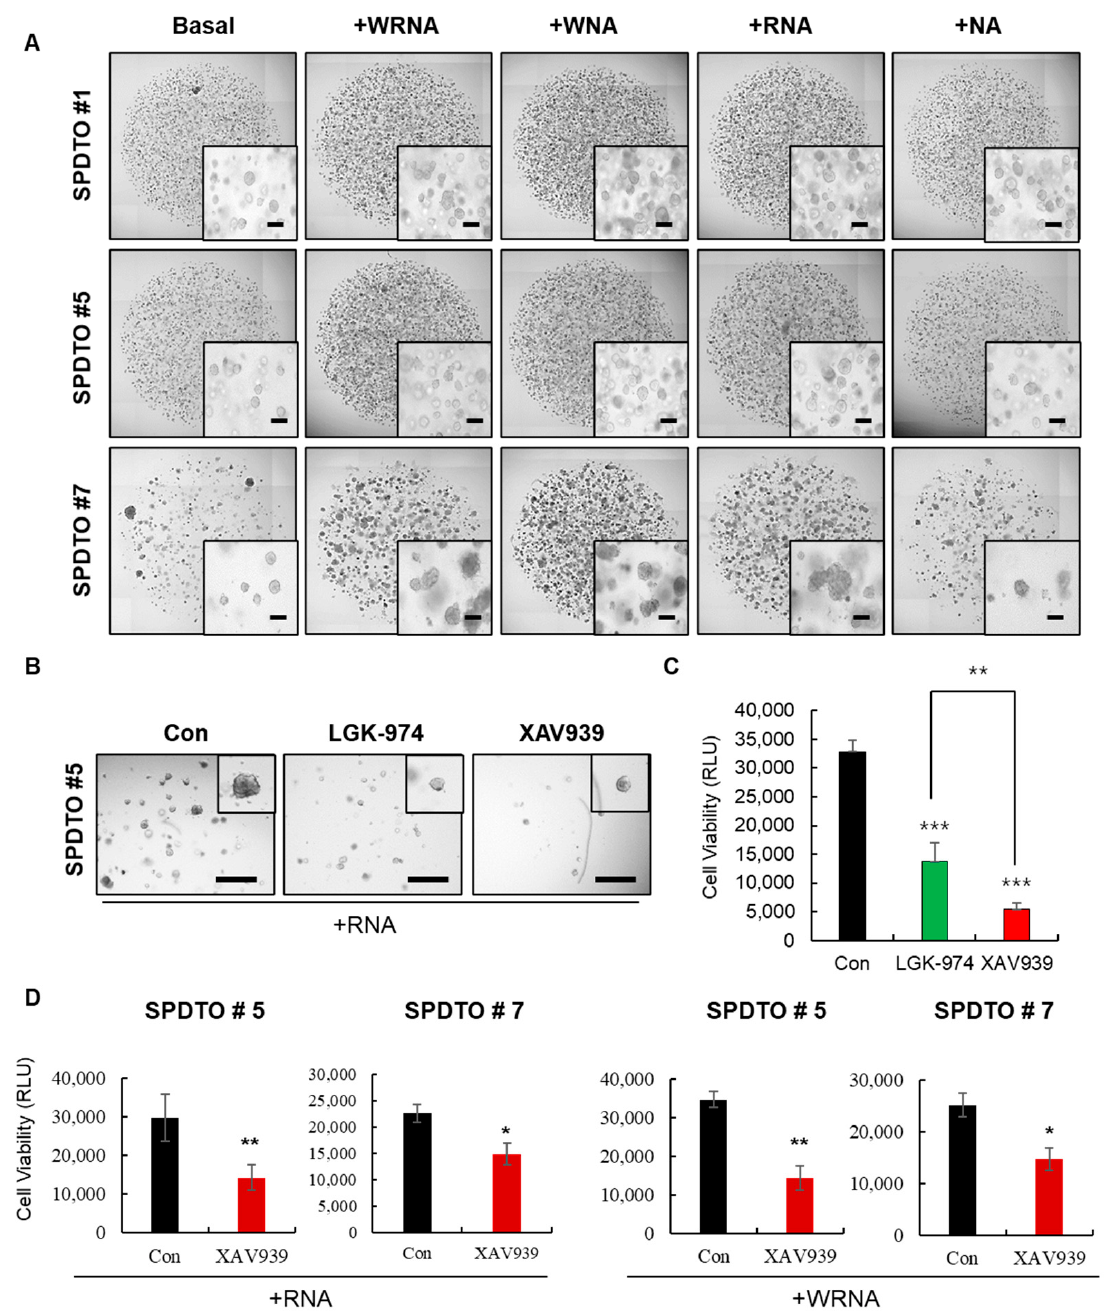
Figure 2. Long term-expansion of SCLC organoids after addition of Wnt3A or R-spondin1. SPDTOs were grown under 5 different culture conditions over 9 months. ( A ) Brightfield images of SPDTO formation in long-term culture under five different culture conditions from passage 7 to passage 12. Basal: medium containing EGF (50 ng/mL) and FGF (50 ng/mL). WRNA: medium containing Wnt3A (100 ng/mL), R-spondin1 (10%), Noggin (100 ng/mL), and A8301 (50 nM). WNA: medium containing Wnt3A, Noggin, and A8301. RNA: R-spondin-1, Noggin, and A8301. NA: medium containing Noggin and A8301. The images are of organoids cultured in the various media after passaging (passage 12) (Scale bars, 200 µ m). ( B , C ) Brightfield images of SPDTO #5 grown with RNA in the presence of 5 µ M LGK-974 or 10 µ M XAV939 (B) and quantification via cell titer assay. Scale bars represent 650 µ m (C). ( D ) SPDTO #5 or SPDTO #7 were grown with 10 µ M XAV939 or DMSO under RNA or WRNA culture conditions. Significance denoted as n.s. not significant, * p < 0.05, ** p < 0.01, or *** p < 0.001. Data were obtained from at least three independent experiments. Con,